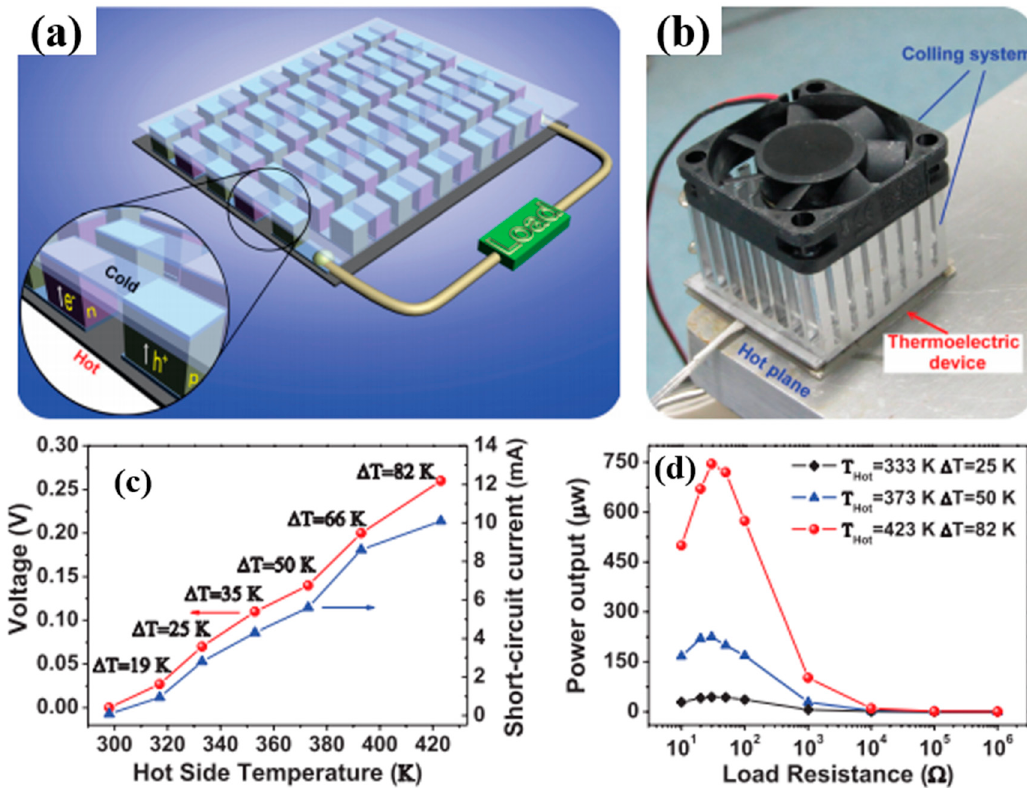
Figure 11. A thermoelectric module consisting of 35 thermocouples. ( a ) Module structure. ( b ) Photograph of the module and the measurement system with a hot plane and cooling fan. ( c ) The output voltage and short ‐ circuit current at various Thot and Δ T. ( d ) The measured power output of the module with different loads. Reprinted with permission from [78]. Copyright 2012 John Wiley and Sons.